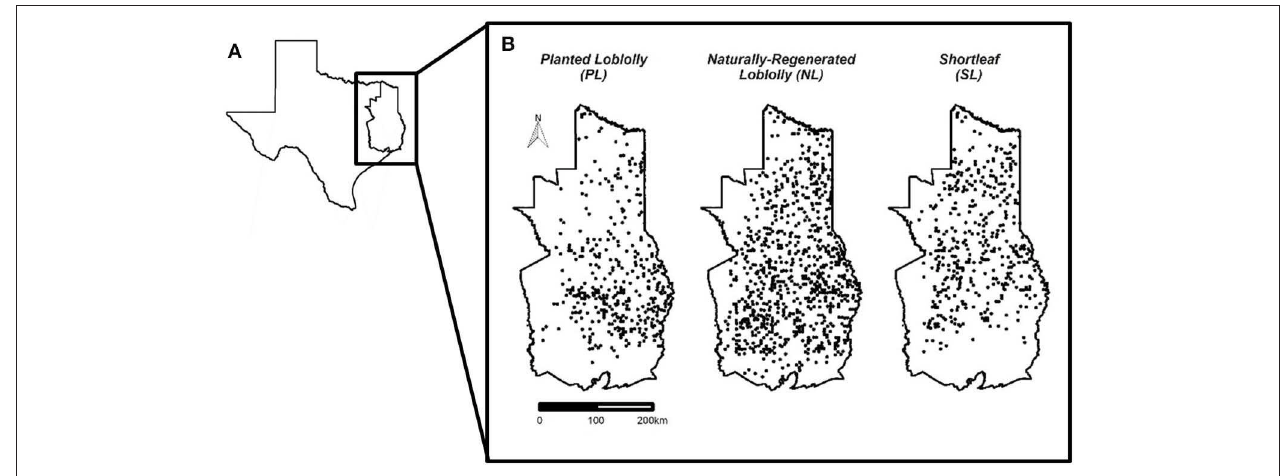
FIGURE 1 | State of Texas map with (A) study area of east Texas as inset and (B) Forest Inventory and Analysis plot locations used for each pine group.